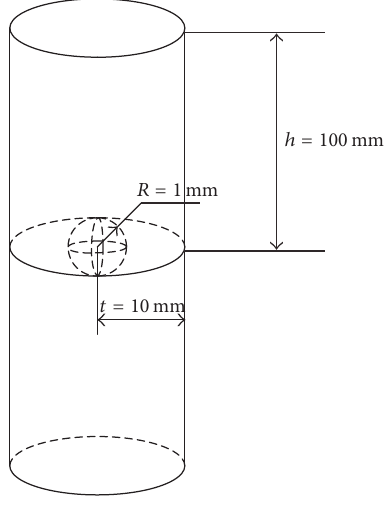
Figure 8: Notched structure of